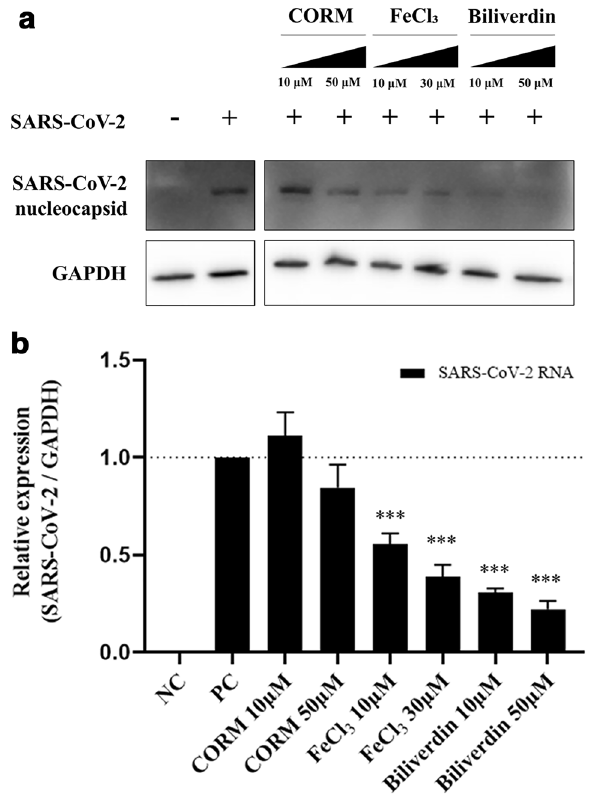
Figure 4. Antiviral efficacy of the metabolites produced by HO-1. The inhibition of SARS-CoV-2 proliferation by carbon monoxide, iron ions, and biliverdin produced by HO-1 was confirmed. Treatment with CORM (releases carbon monoxide), FeCl 3 , and biliverdin was performed 1 h before SARS-CoV-2 infection. At 24 h post-infection, ( a ) western blot assay (also see Supplementary Fig. S4d) and ( b ) qPCR were performed to compare the changes in the viral protein and RNA contents. *** P <